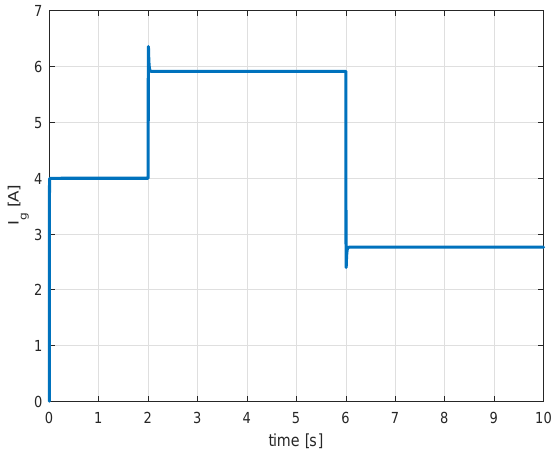
Figure 10. Simulation Case: Generator current.